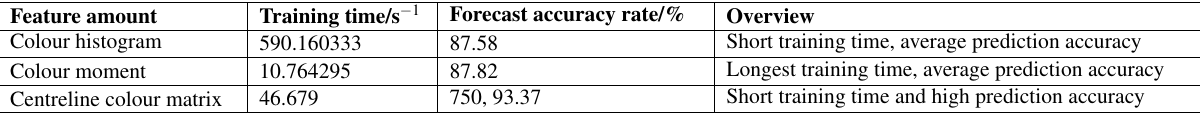
Table 5 Comprehensive comparison of three diagnostic